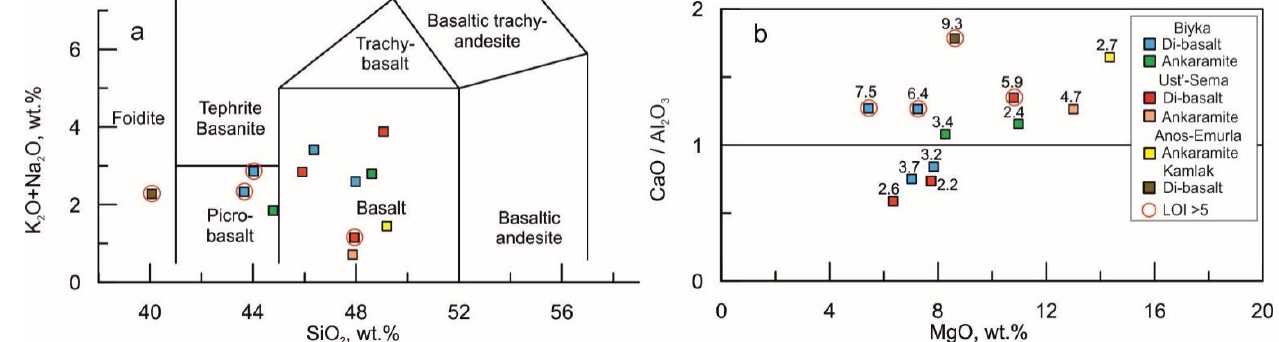
Figure 4. ( a ) TAS diagram [25] and ( b ) variations in MgO vs. CaO/Al 2 O 3 for the volcanic rocks of the Ust’-Sema Formation, Gorny Altai. The values indicate the loss on ignition (LOI). The ankaramites were characterized by high contents of MgO (8.27 – 14.34 wt.%), CaO